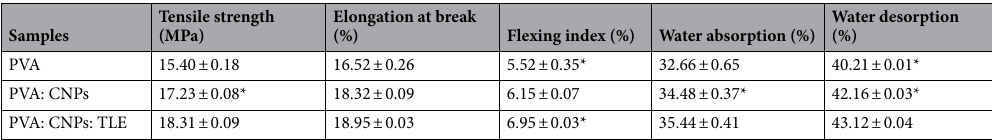
Table 1. Mechanical properties of PVA, PVA: CNPs, and PVA: CNPs: TLE. The data are presented as the mean ± SD of three individual experiments. *p < 0.05. Compared to PVA, using Duncan’s multiple range analysis.